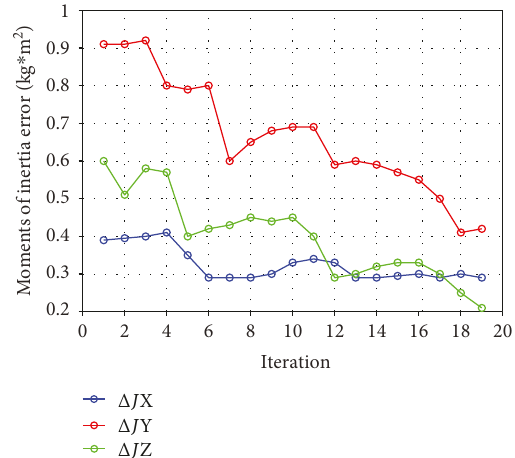
Figure 6: Di ff erence between diagonal elements of tensor of